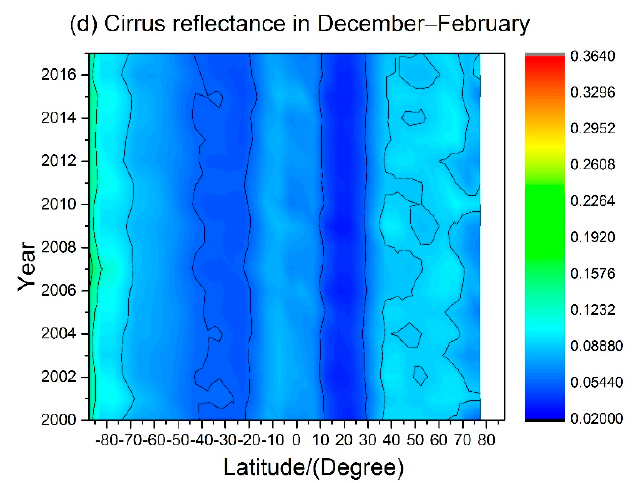
Figure 6. The seasonal-average cirrus reflectance vs. latitude from 2000 to 2017. ( a ) March-May, ( b ) June-August, ( c ) September-November, ( d ) December-February. Note that there are no data for ( b ) and ( d ) in the [80 ◦ S, 90 ◦ S], [80 ◦ N, 90 ◦ N] regions, respectively, due to the Polar nights or very short sunshine time.